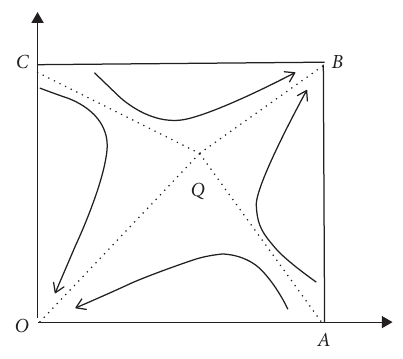
Figure 8: Comprehensive game process of A and B